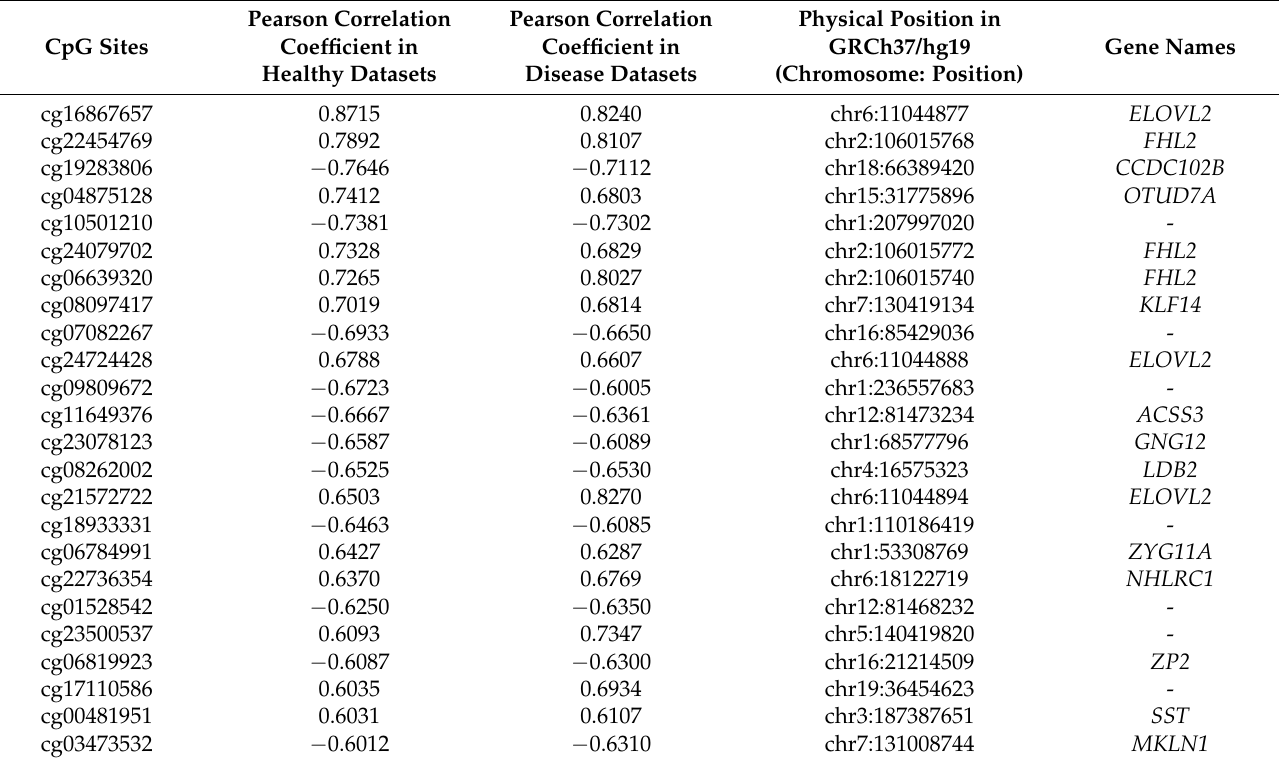
Table 5. Information about the twenty-four common CpG sites for healthy and rheumatoid arthritis datasets.